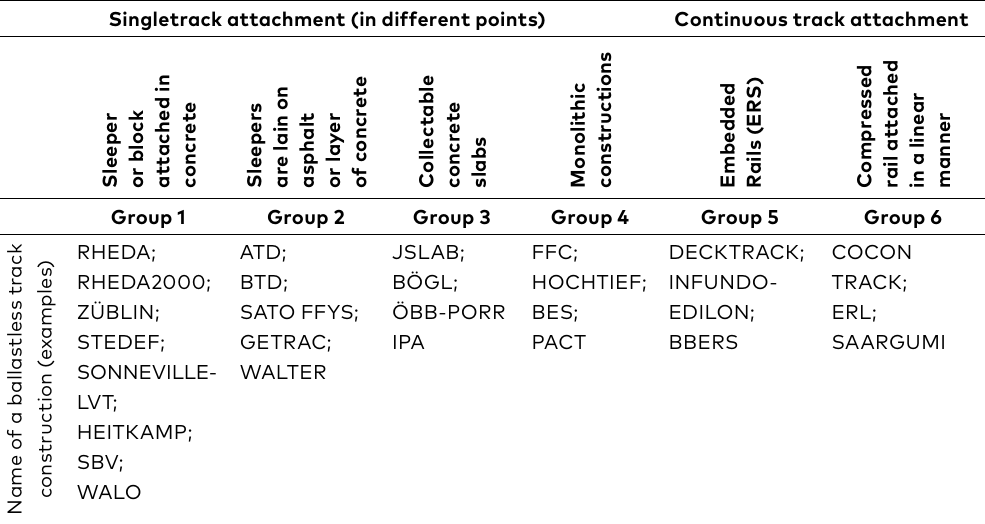
Table 1. Classification of slab track constructions Singletrack attachment (in different points) Continuous track